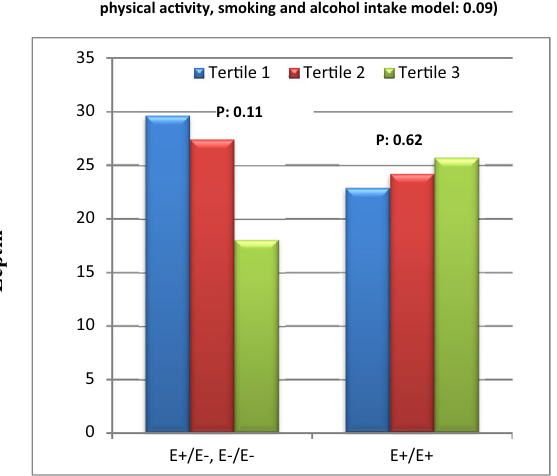
Figure 5. Interaction between Apo B EcoR1 SNP and HEI-2015 on serum leptin